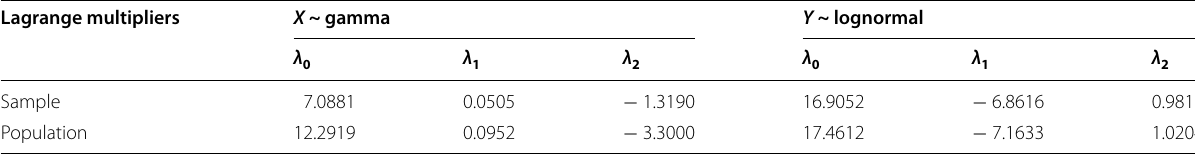
Table 1 Lagrange multipliers estimated from sample dataset and the true population Lagrange